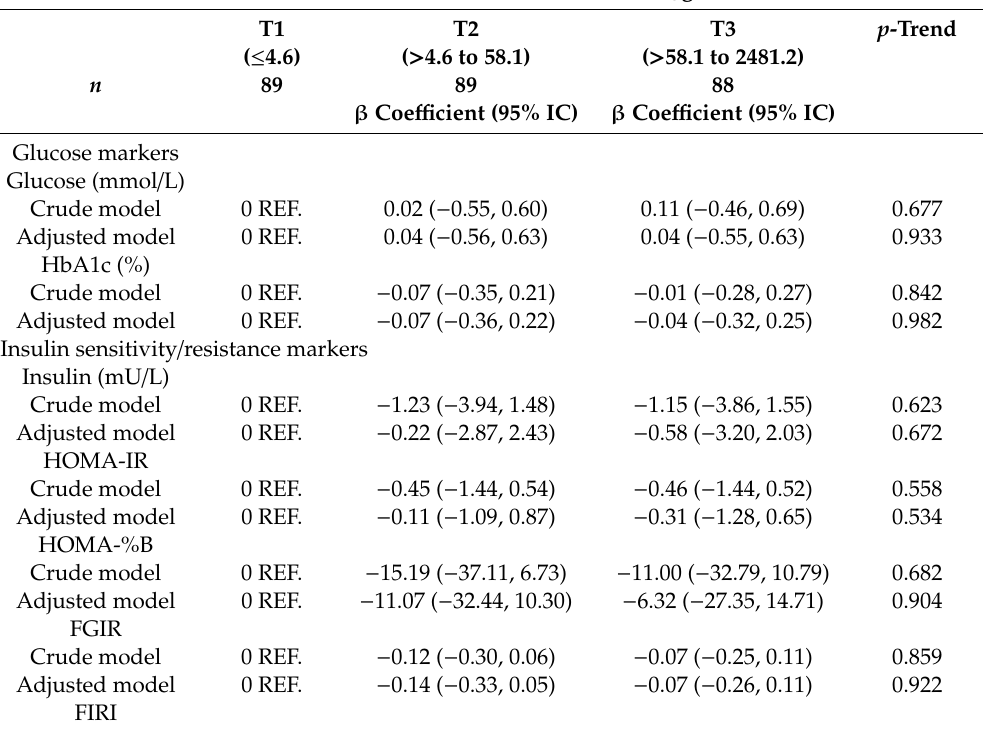
Table 3. Linear regression analysis distributed in tertiles evaluating the associations between total urine resveratrol (independent variable) and glucose metabolism markers (outcome) in participants with